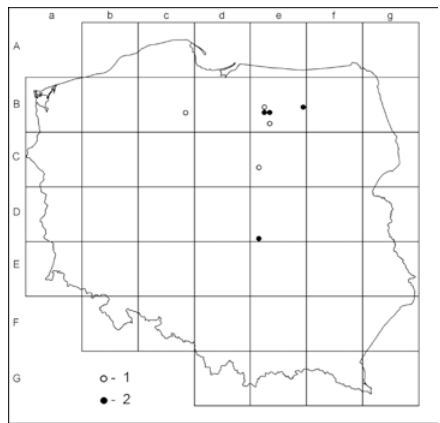
Fig. 1. Rinodina degeliana localities in